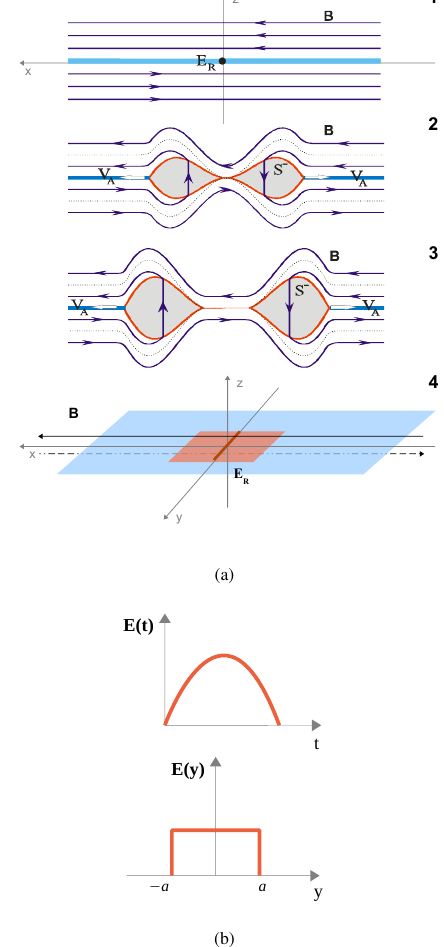
Fig. 1. (a) Stages of reconnection according to the non-steady Petschek-type reconnection model with a finite-sized X-line. Panels 1 and 2 illustrate the switch-on and growing phases respectively; panel 3 illustrates the switch-off phase and detaching of the outflow regions. S − marks the slow shock fronts on Panels 2 and 3. Panels 1–3 are adapted from Kiehas et al. (2009). Panel 4 illustrates the X-line in the y-direction across the current sheet. (b) Configuration of the model electric field, as a functions of time, E ( t ) , and of y , E ( y ) .